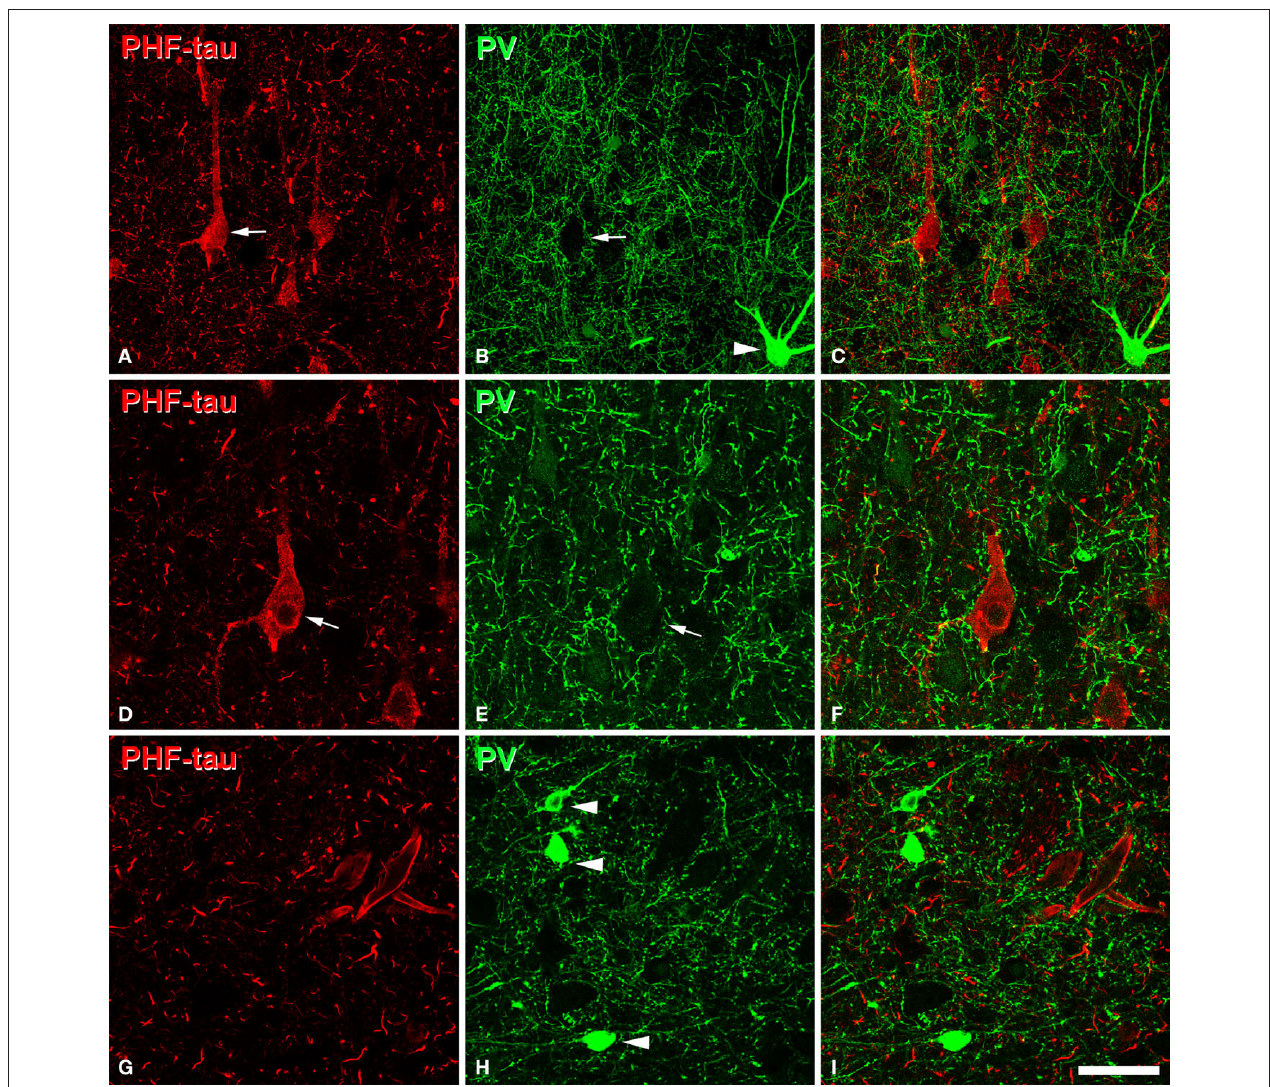
FiGure 13 | (A,B) , pairs of confocal images (stacks of 10 optical sections; step size: 1.04 μm) to illustrate that PV-ir axon terminals (green) are preserved around the somata of PHF-tau-ir neurons (red) in CA1 (patient P7). (D,e) , pairs of single confocal sections showing an PHF-tau-ir pyramidal cell (also indicated in (A) with an arrow) to illustrate its perisomatic innervation by PV-ir axon